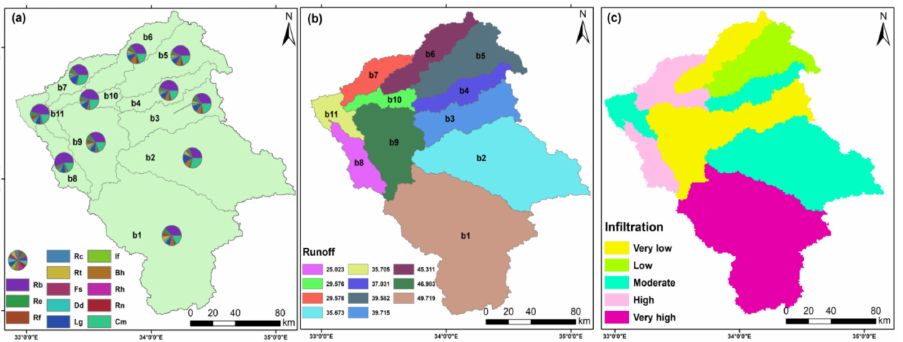
Figure 8. Morphometric analysis of studied basins: ( a ) distribution of the morphometric parameters in the studied sub-basins; ( b ) runoff potential map; ( c ) infiltration potential